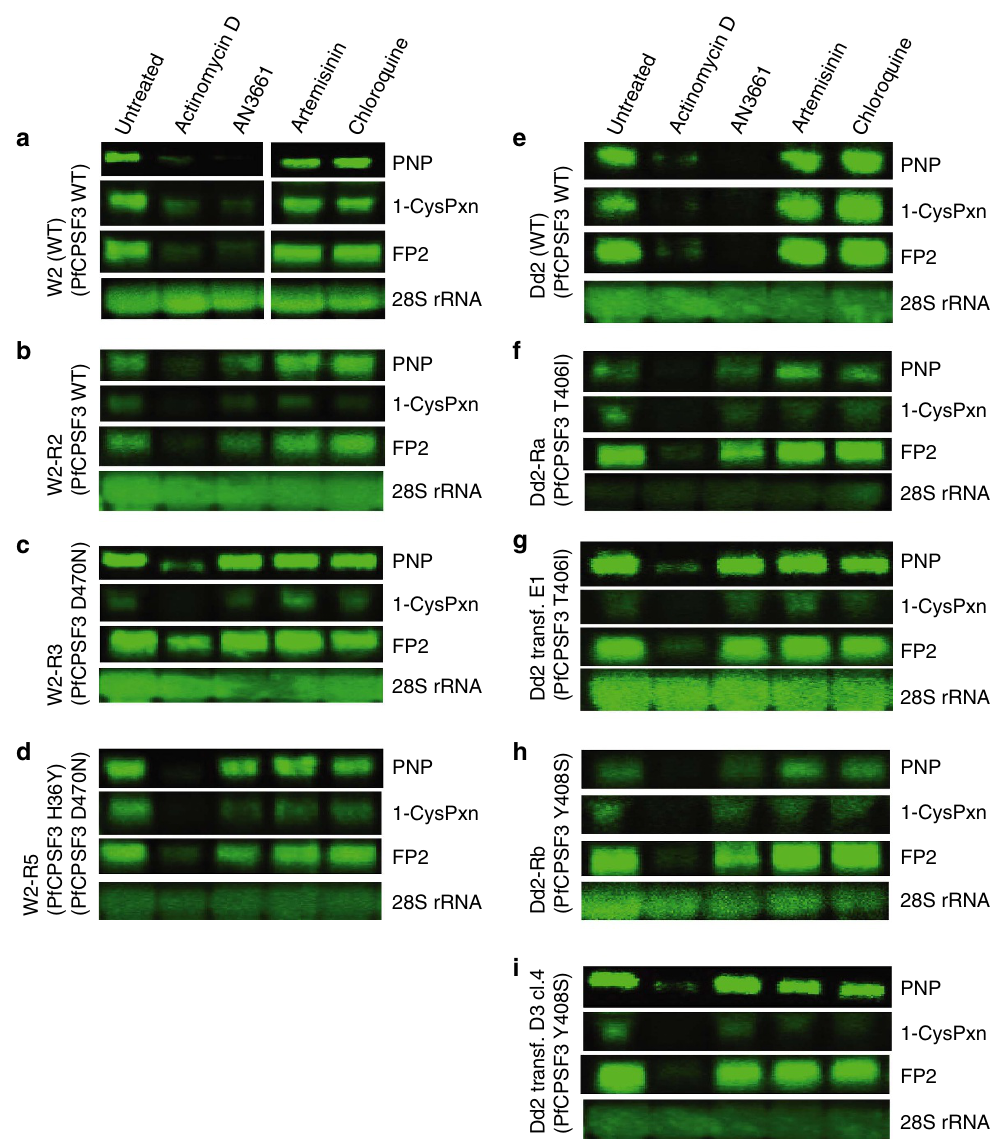
Figure 7 | mRNA stability in the presence of AN3661. Northern blots shown are of parasite lines labelled as defined in Figs 3 and 4 ( a–i ) that were treated for 4h with DMSO (untreated), actinomycin D, AN3661, artemisinin or chloroquine. RNA was then processed and the transcripts for purine nucleoside phosphorylase (PNP), 1-cys peroxiredoxin (1-CysPxn) and FP2 were detected and imaged as described in ‘Methods’ section. Levels of 28S rRNA were examined as a loading control. The figure shows results from a single experiment. Two additional experiments yielded the same